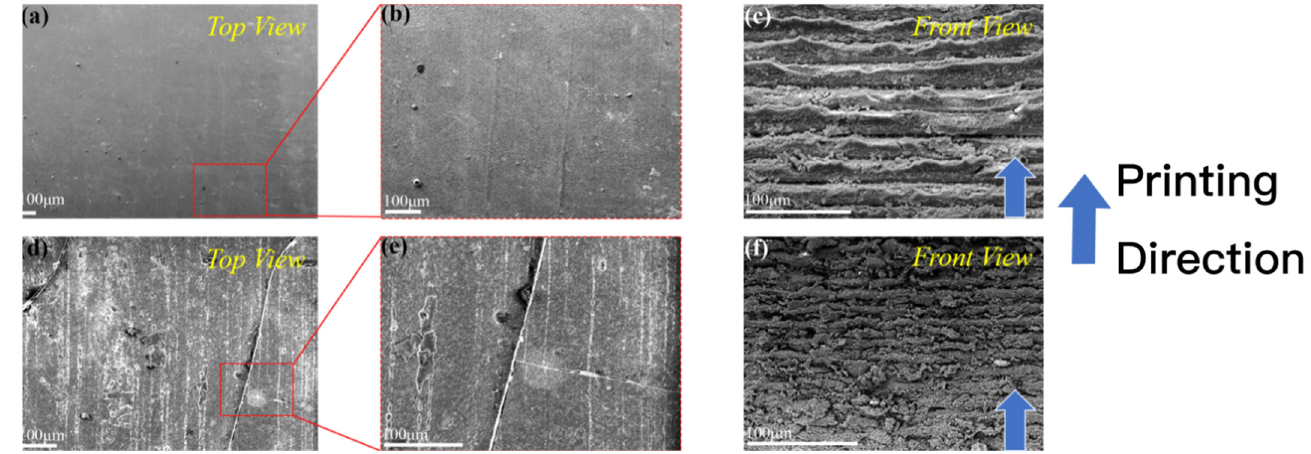
Figure 10. The SEM images of 3D printing ZrO 2 specimen. ( a – c ): before sintering; ( d – f ): after sintering